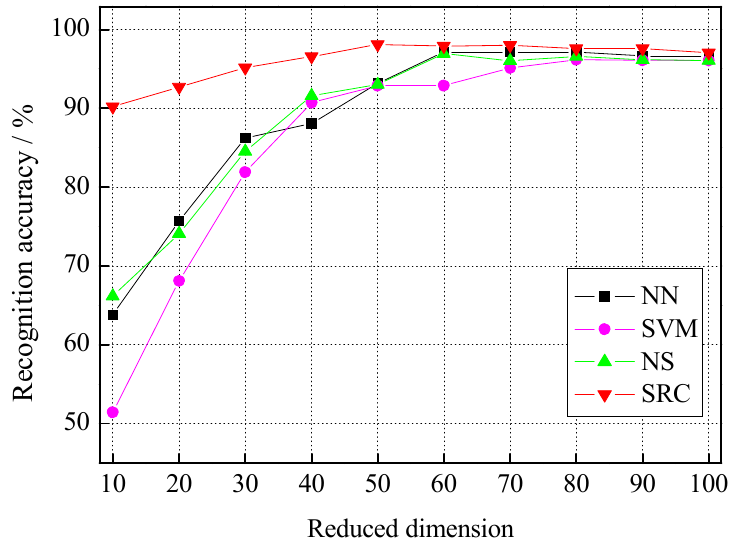
Figure 4. Recognition results of different methods with reduced dimension of Gabor wavelets